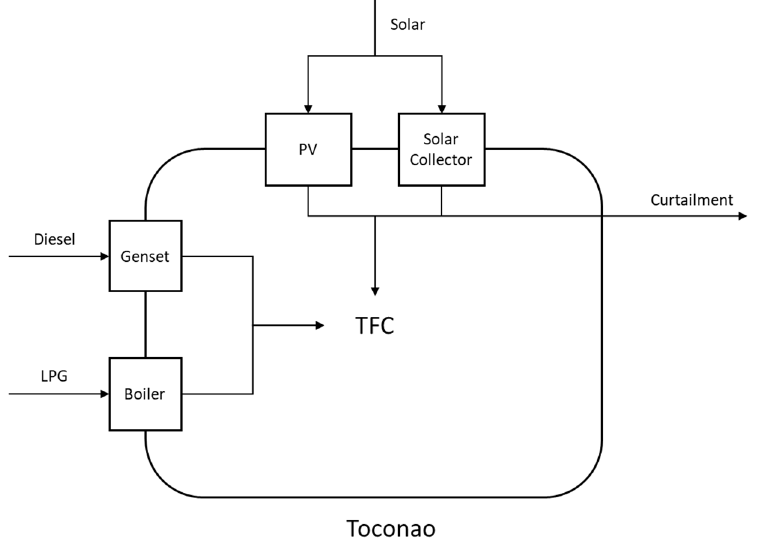
Figure 1. Conceptual scheme of the village of Toconao for energy accounting purposes.